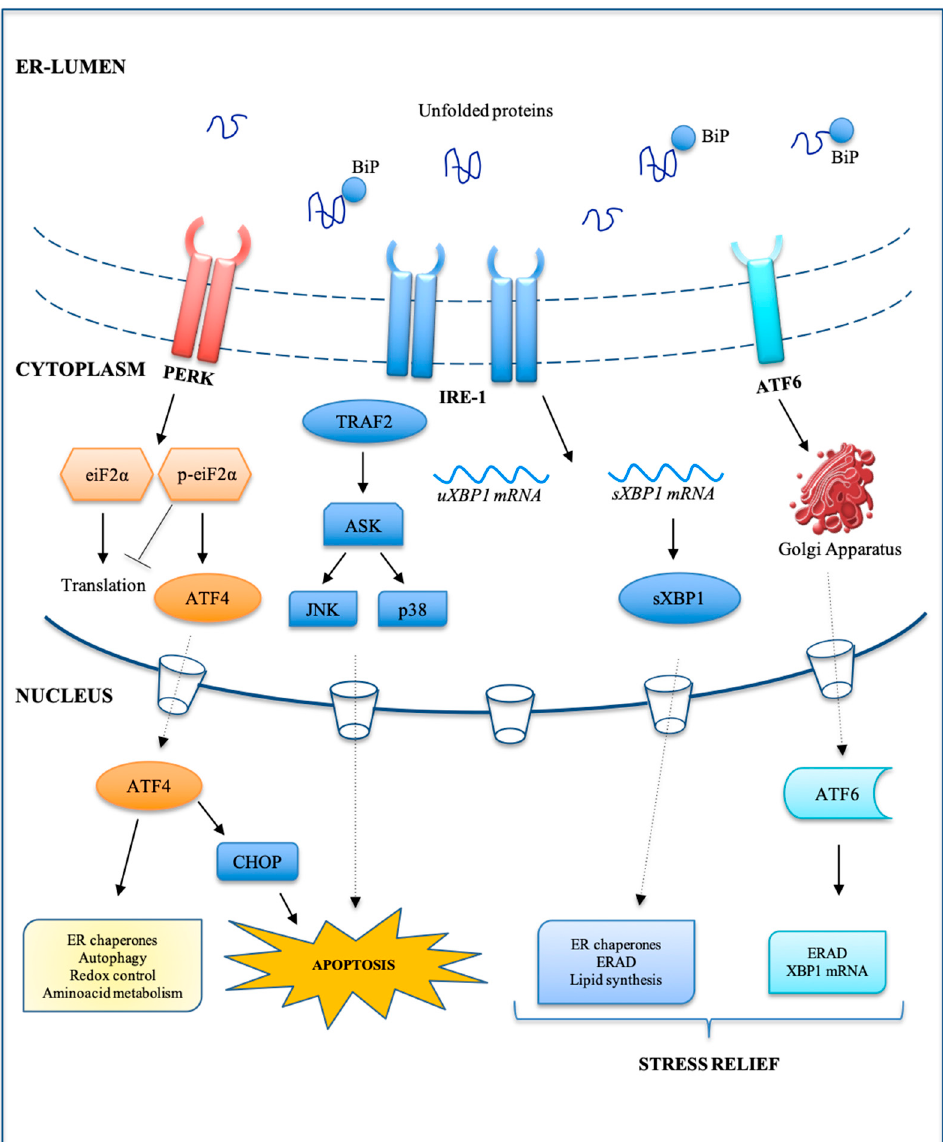
Figure 3. Schematic representation of unfolded protein response (UPR) response. The UPR signal is driven by three different endoplasmic reticulum (ER) transmembrane sensors: protein kinase RNA(PKR)-like ER kinase (PERK), inositol requiring enzyme1 α (IRE-1) and activating transcription factor 6 (ATF6). Upon unfolded protein accumulation, binding immunoglobulin protein (BiP) dissociates from IRE1 and PERK, whereas ATF6 translocates to the Golgi apparatus, to be activated. The activation of these three branches leads to the activation of their downstream pathways.